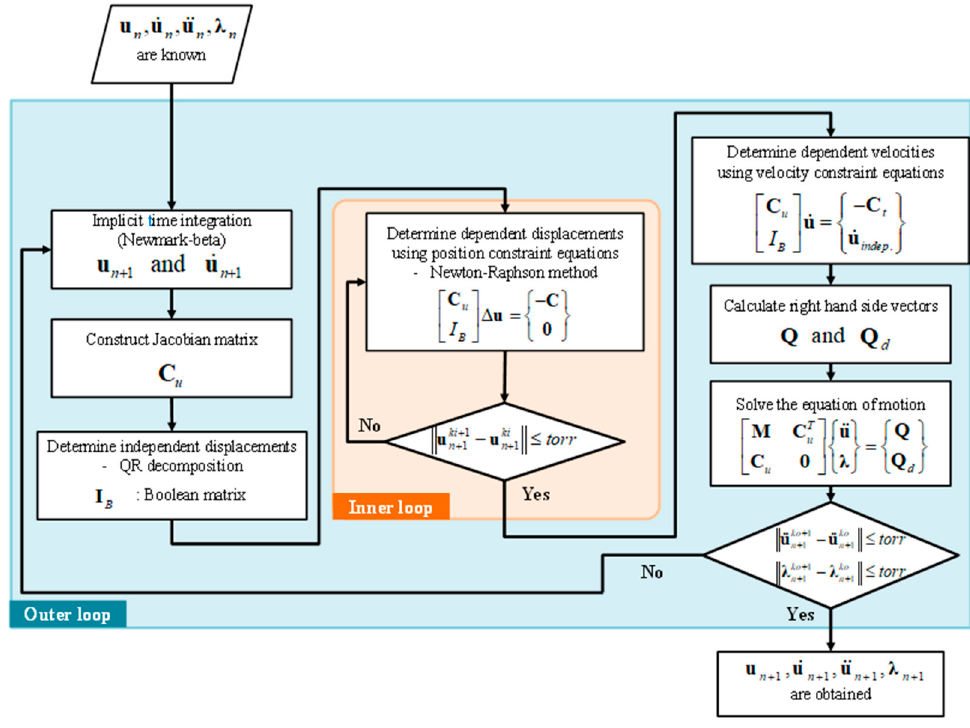
Figure 2. Two-loop procedure for the implicit time-integration method.